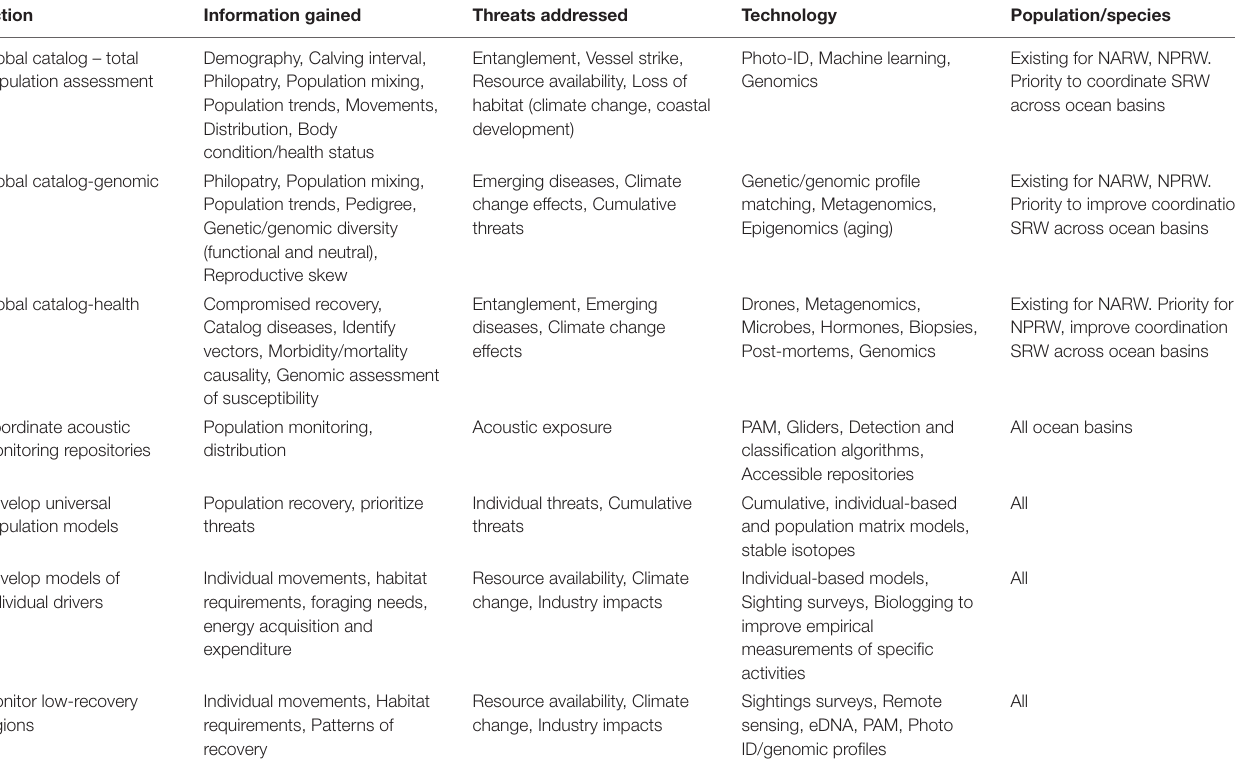
TABLE 2 | Global right whale research